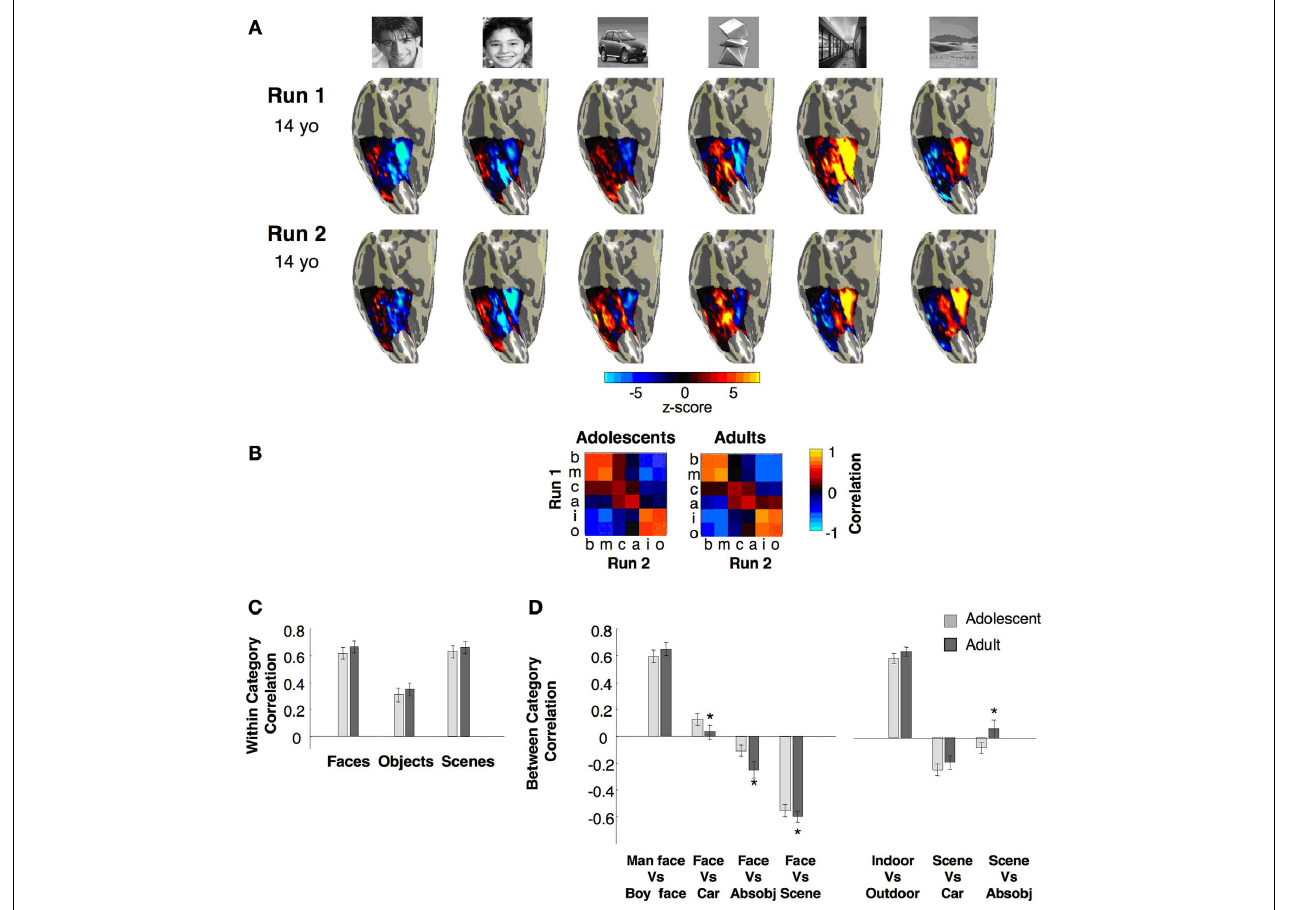
FIGURE 10 | Multivoxel pattern (MVP) analysis of distributed responses to categories across the right VTC. (A) Visualization of the MVP to stimulus categories in run1 and run2 in a representative 14-year-old adolescent. (B) Group averaged Pearson correlations within and between categories from run1 versus run2. The on-diagonal components indicate the within-category reproducibility of the MVPs across runs, using different exemplars of the same stimulus category.